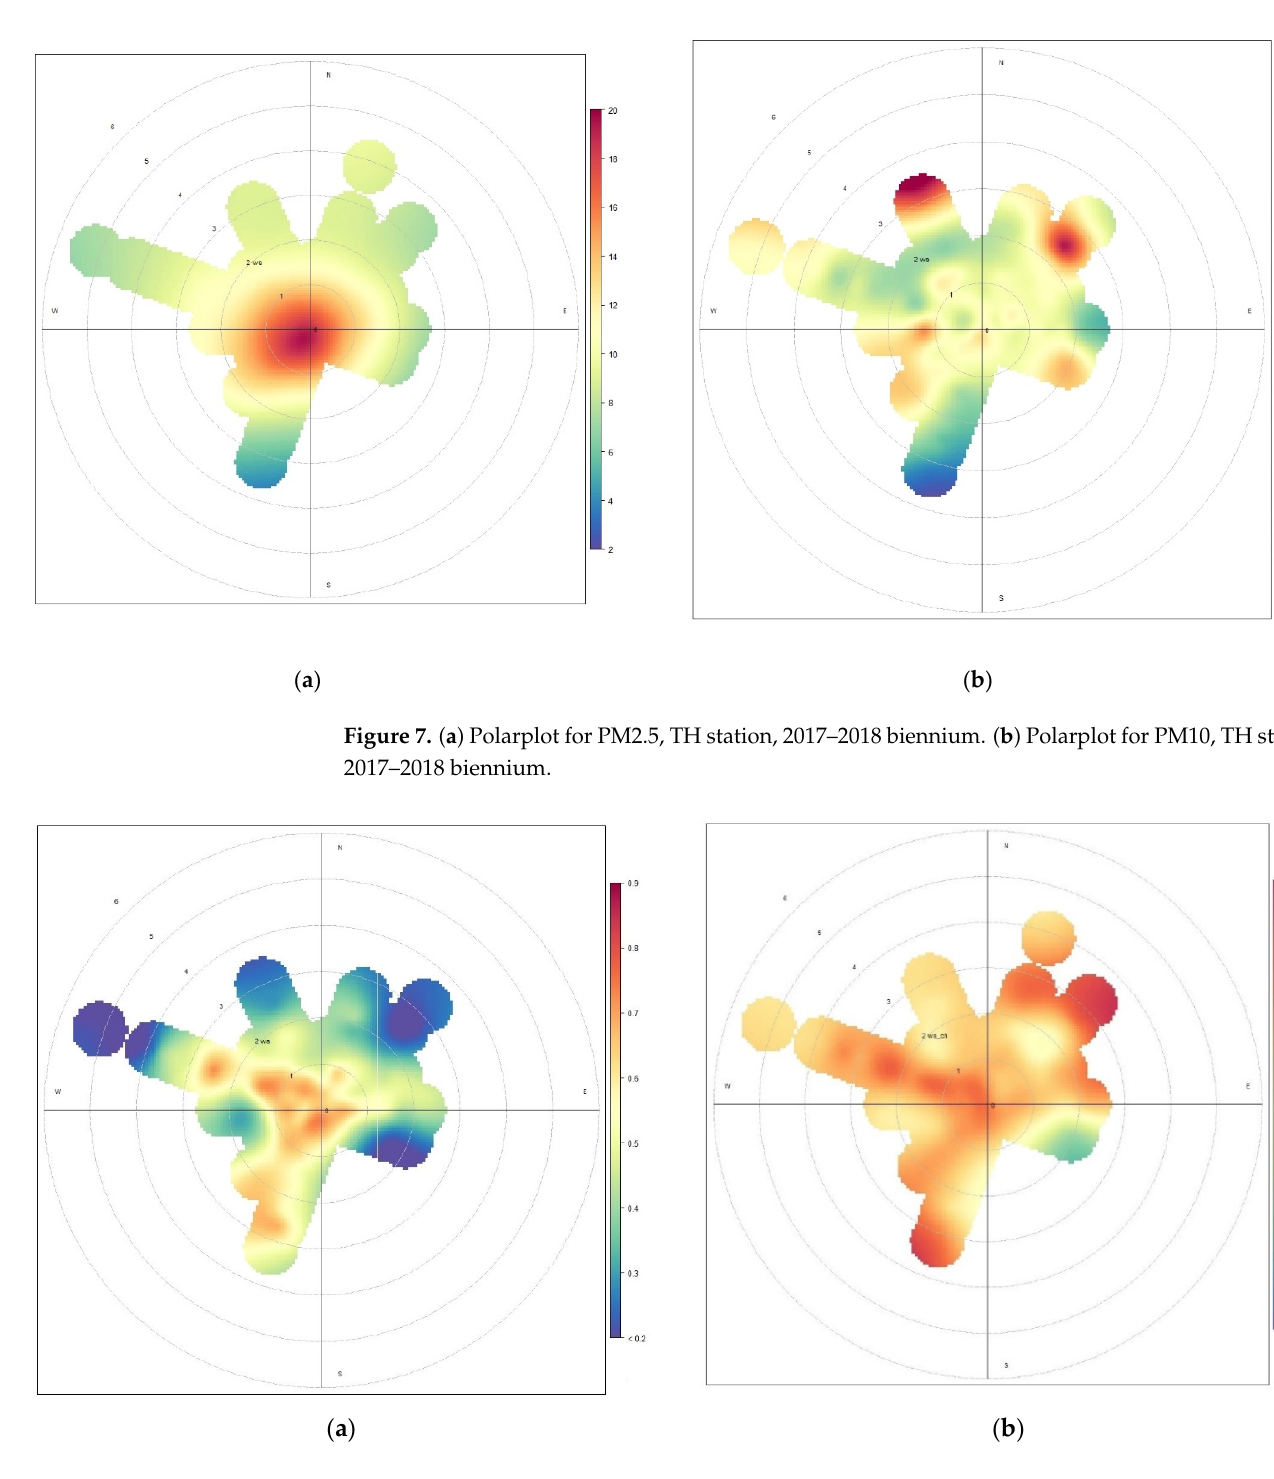
Figure 6. ( a ) Seasonal Windrose (winter semester) for the Pescara weather station, 2017–2018 two- year period. ( b ) Seasonal Windrose (summer semester) for the Pescara weather station, 2017–2018 two-year period.